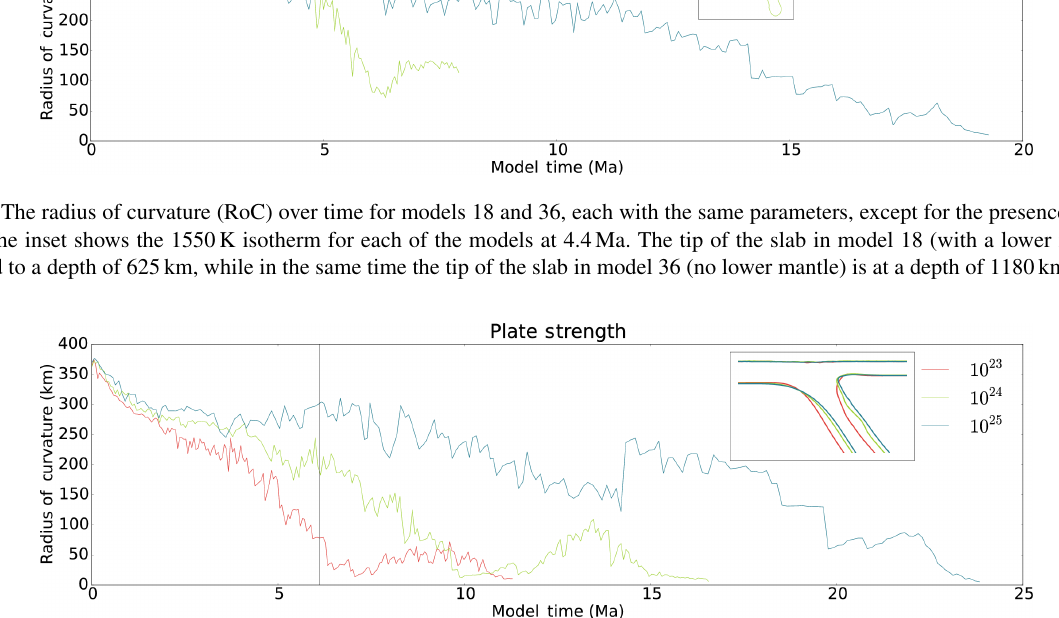
Figure 6. The change in radius of curvature over time for three models of different plate strength, models 11, 14, and 17. The inset shows the 1550K isotherm at the plate